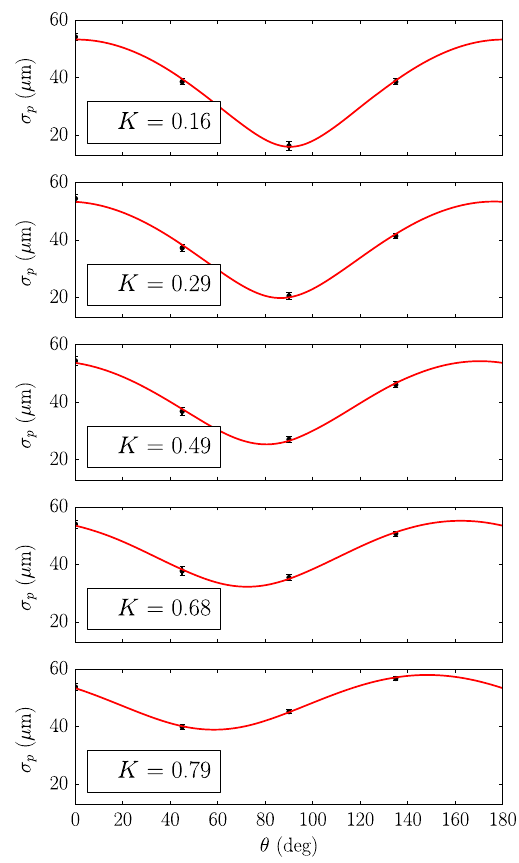
FIG. 11. Fit of projections taken at 0°, 45°, 90°, and 135° to reconstruct the ellipse taken at different couplings ( K ). Black dots are real data, while the red lines are obtained by